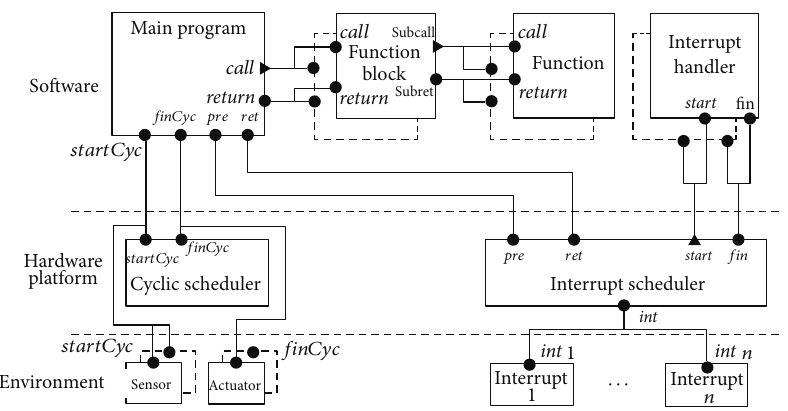
Figure 1: PLC system